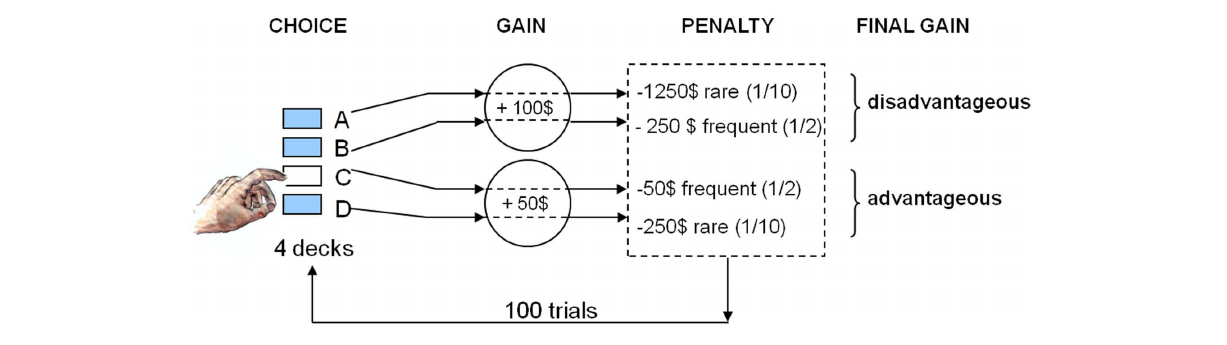
FIGURE 1 | Schematic set-up of the Iowa gambling